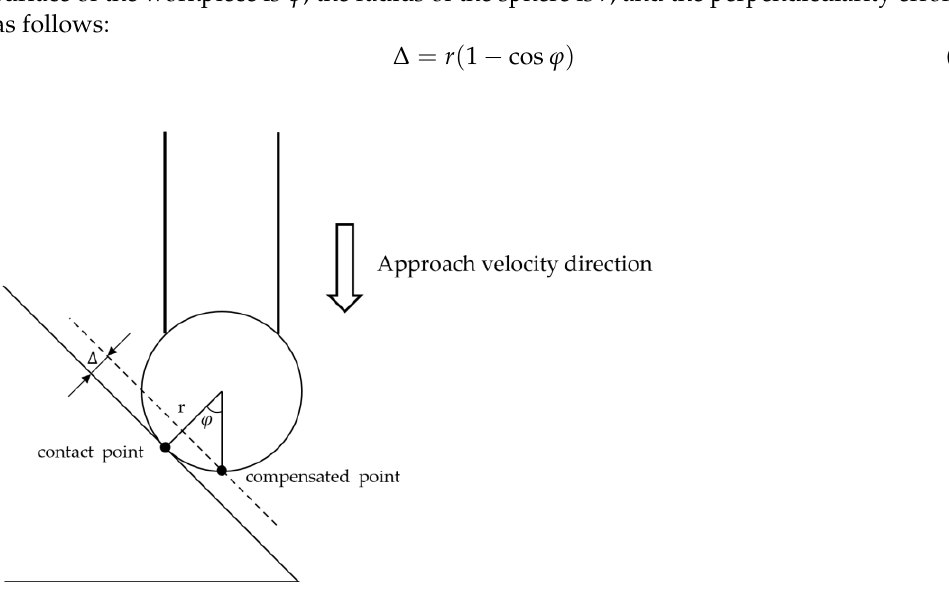
Figure 9. Schematic diagram of perpendicularity error.